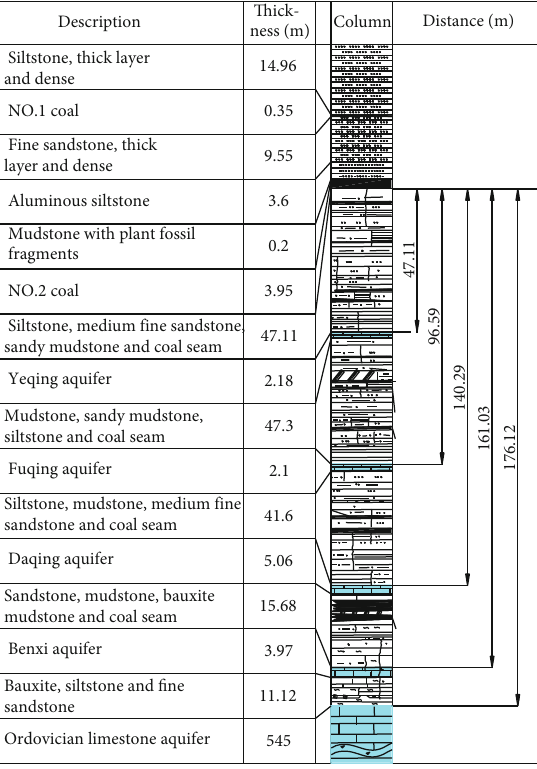
Figure 2: Stratigraphic column of seam, roof, and fl oor strata.